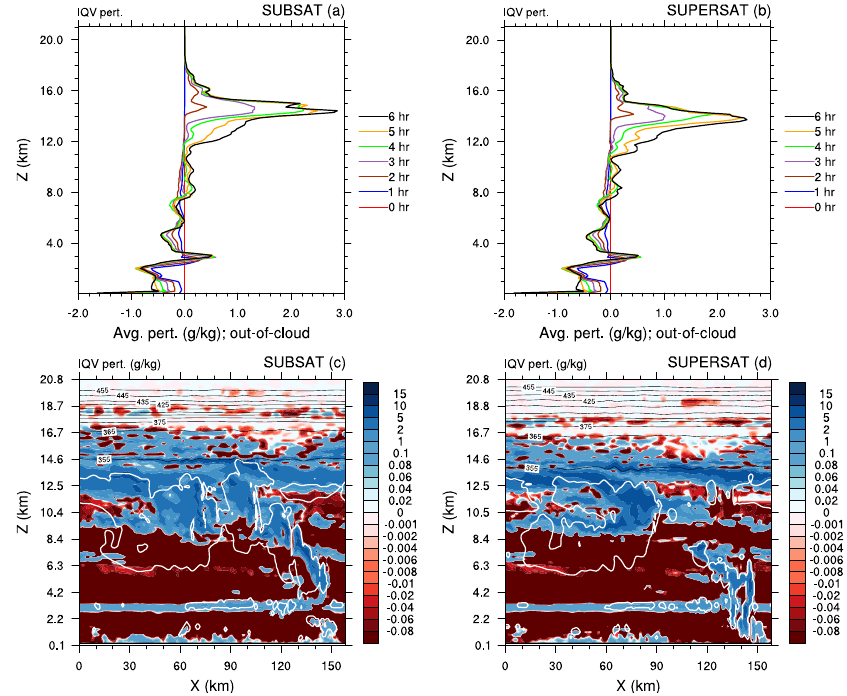
Fig. 9. IQV perturbation (gkg − 1 ) for SUBSAT and SUPERSAT cases. (a, b) Average out-of-cloud profile. (c, d) Vertical cross-sections, taken at y = 75km in each case, at 6h. The colour scale used in the vertical slices is not symmetric around zero, but chosen to reflect the logarithmic nature of water vapour content with height. The total cloud mixing ratio of 0.01gkg − 1 is also shown in